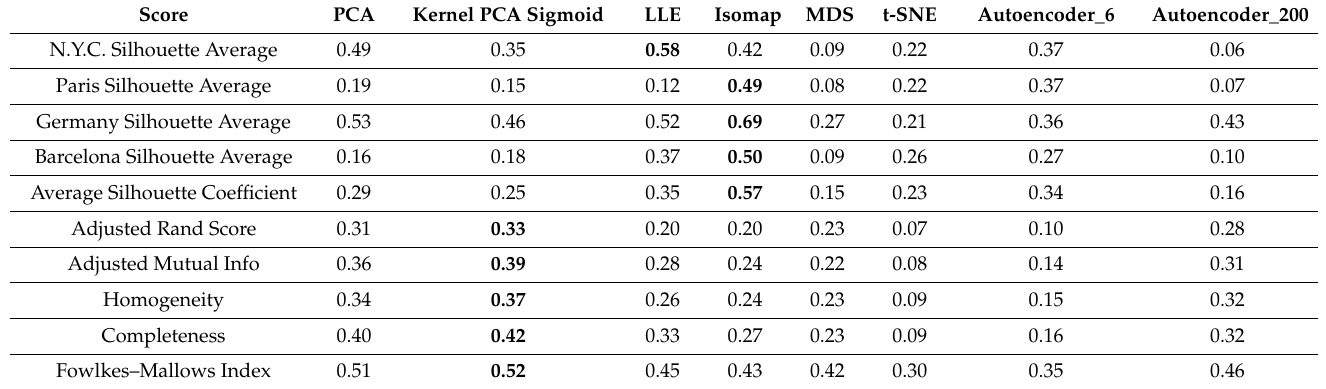
Table 3. Resulting metrics of used methods when fixing the cluster count value to